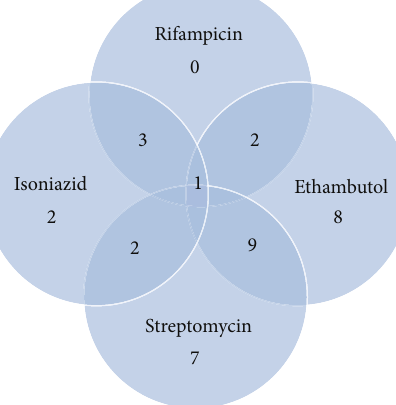
Figure 1: Resistance to one or more drugs in cultures of all TB subjects.